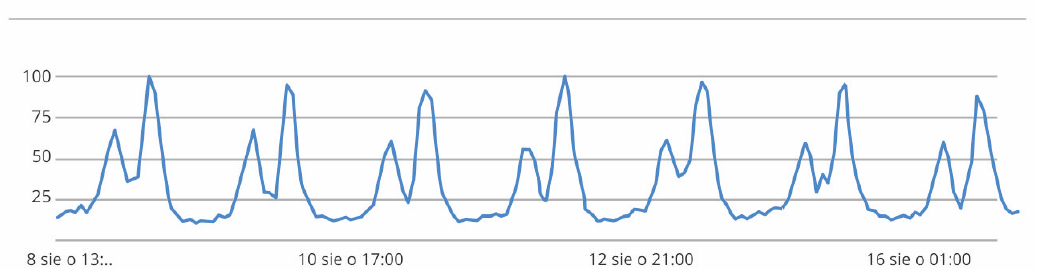
Figure 3. Frequency of searches for the keyword “litany” over a week; source: Google Trends, https://www.google.com/trends (accessed on 16 August 2021).